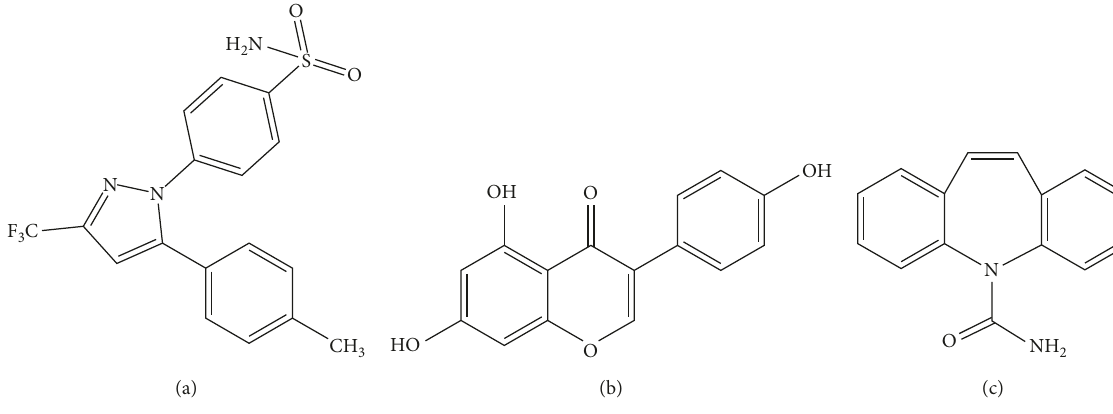
Figure 1: Chemical structures of three substances: (a) genisten, (b) celecoxib, and (c)